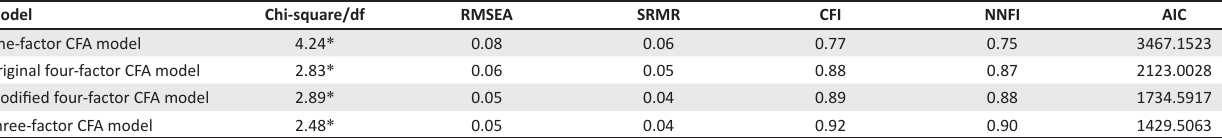
TABLE 3: Positive coping behavioural inventory model fit statistics: Competing measurement models. Model